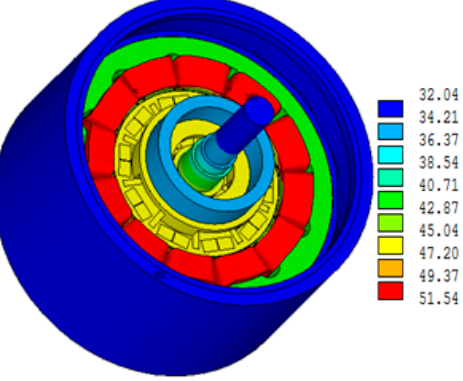
Figure 8. 3d temperature distributions of machine operating at rated torque of 8.6 N m and 0 At Axial Magnetic Motive Force (AMMF) (°C).